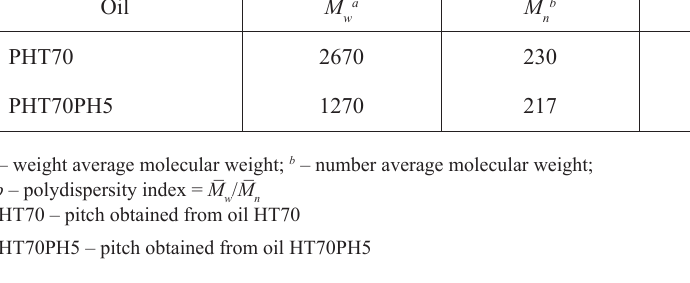
Table 8. Analysis of the pitches by SEC Oil M̅ wa M̅ nb I PHT70 2670 230 11.6 PHT70PH5 1270 217